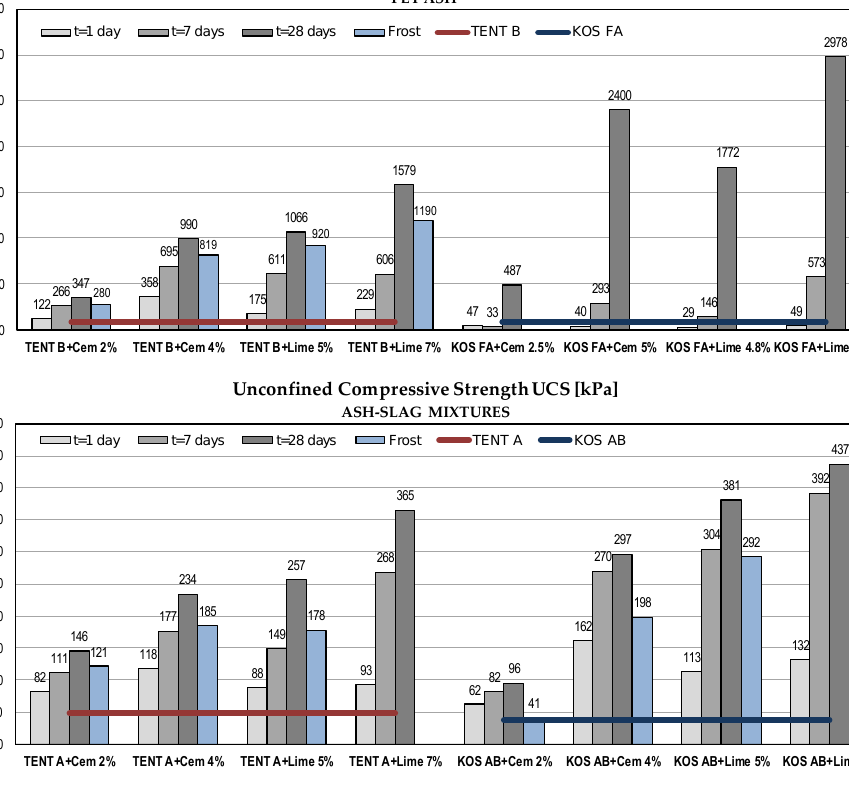
Table 6. Mechanical properties of tested materials without binders.